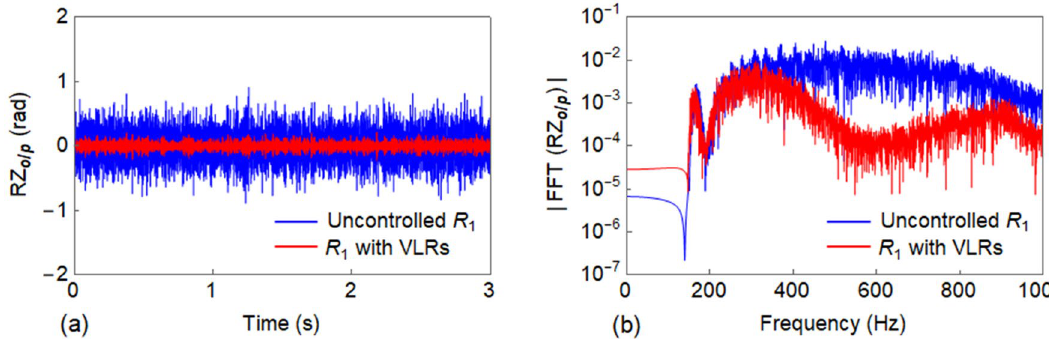
Figure 13. Comparison between the response of uncontrolled R 1 against R 1 with VLRs in vertical direction: ( a ) output response ( RZ o / p ); and ( b ) FFT ( RZ o / p